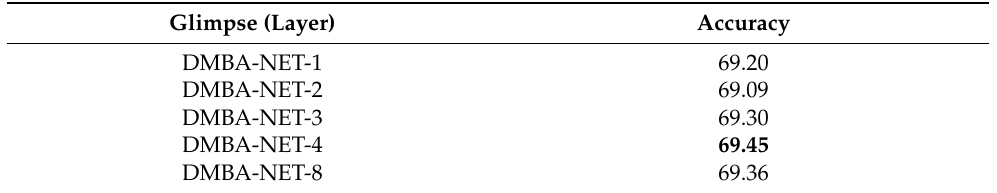
Table 3. Validation scores on VQA2.0 dataset for the number of glimpse of our models. DMBA-NET-L denotes the model has L layer.